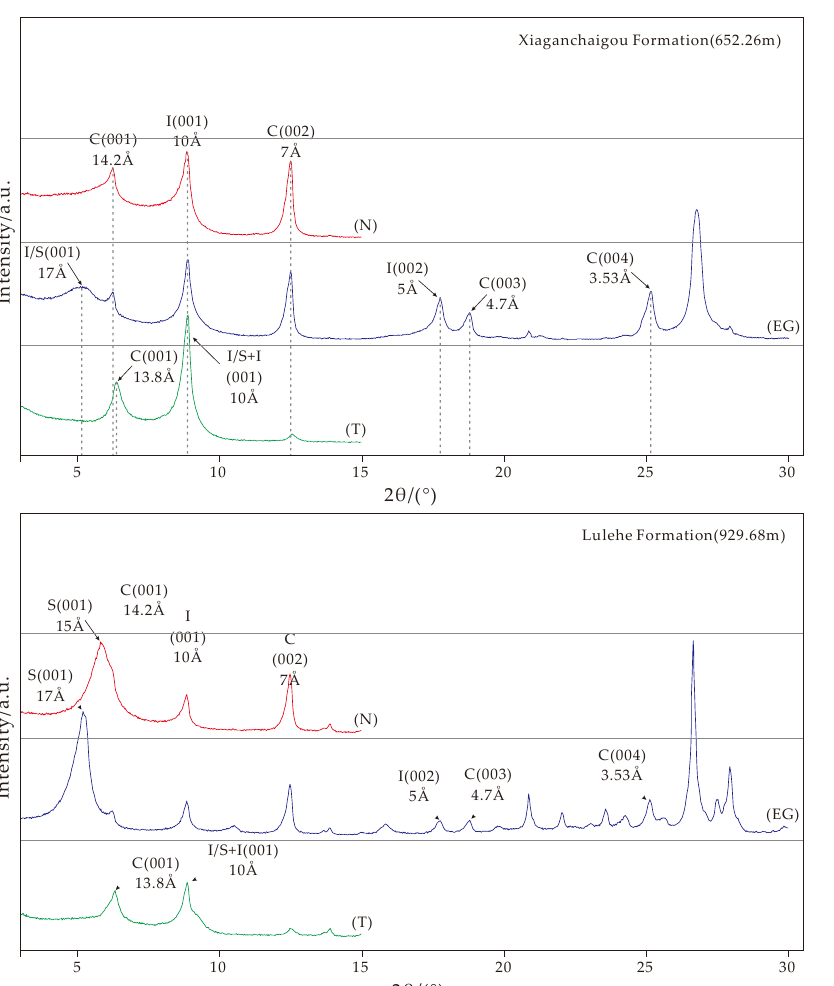
Table 1 for calculation results.